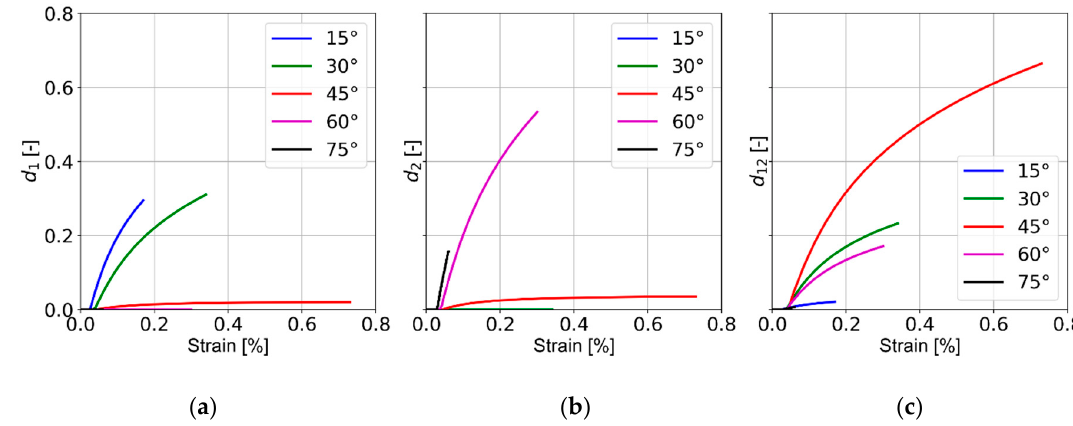
Figure 5. Comparison between damage values from the model with global strain values obtained from tensile tests for C/C–SiC with ( a ) 𝑑 (cid:2869) , ( b ) 𝑑 (cid:2870) and ( c ) 𝑑 (cid:2869)(cid:2870) .